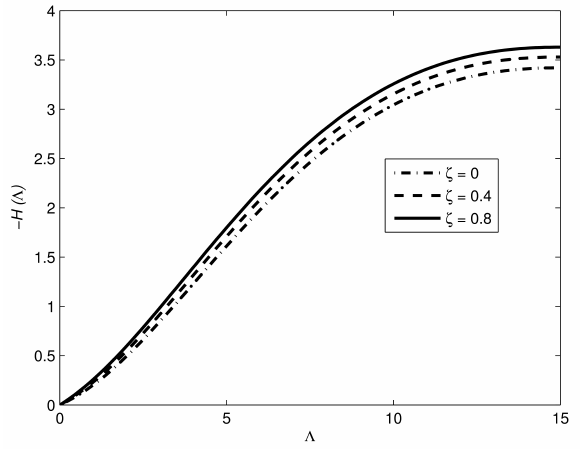
Figure 13: Effect of C 3 on − P ( Λ ) keeping ζ = η = 0.5 , C 1 = C 2 = 400 , Br = 1 , Pr = 6.8 , and Re =